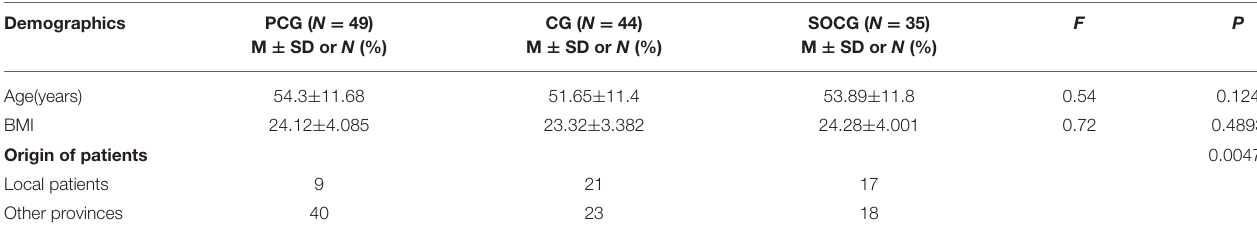
TABLE 1 | Baseline demographical data of all patients